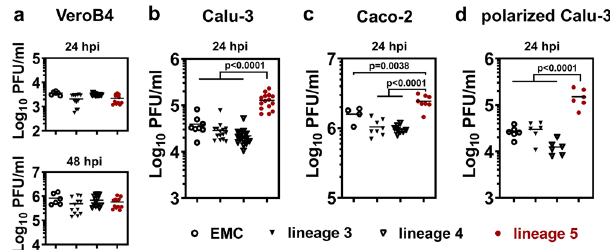
Fig. 2 Enhanced replication of lineage 5 MERS-CoV isolates on cultured cells. Cells were infected at MOI = 0.002 and virus progeny in cell culture supernatants was quanti fi ed by plaque assays. a Vero B4 cells, 24 and 48 hpi; b Calu-3 lung cells, 24 hpi; c Caco-2 colon cells, 24 hpi; d Calu-3 lung cells grown as air-liquid interface culture, 24 hpi. All infections were lineage as documented in Supplementary Table 1. Shown are in a the results of n = 2 independent experiments with n = 2 MERS-CoV isolates per lineage and biological triplicates. In b the results of n = 4 independent duplicates. In c the results of n = 2 independent experiments with n = 2 MERS-CoV isolates per lineage and biological duplicates. In d the results of n = 2 independent experiments with n = 1 MERS-CoV isolate per lineage and biological triplicates.; Statistical signi fi cance in difference of PFU/ml between groups was determined by one-way ANOVA, followed by multiple two-tailed Student´s t -tests between lineage 5 and other lineages. PFU, plaque forming units; hpi, hours post